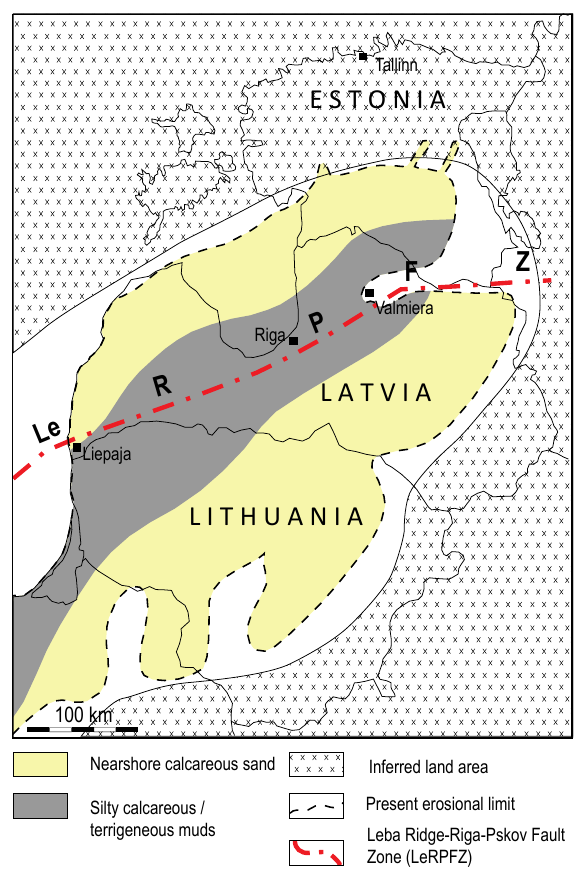
Fig. 6. The facies/thickness distribution of the Baltic Basin with the Livonian Tongue around the LeRPFZ in Aeronian (Raikküla) time and locations of the early Silurian Raikküla and Jaani time depressions on the Scandinavian side of the LeRPFZ (modified after Kaljo & Jürgenson